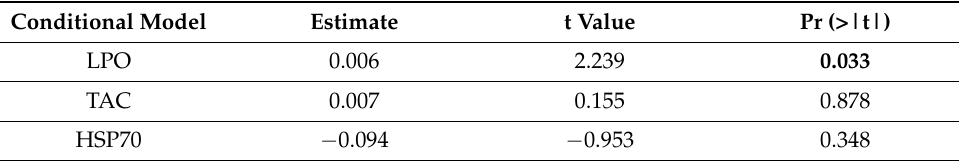
Table 6. Effect of Control (CT) and High (HT) temperature treatments on larvae of two-spotted goby,